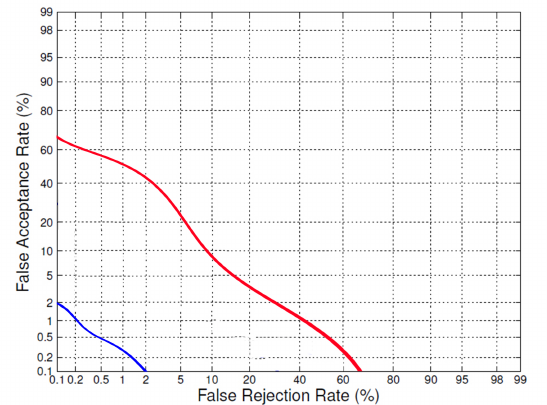
Figure 2. Licit scenario vs. spoof scenario of the biometric system for auditory based human age